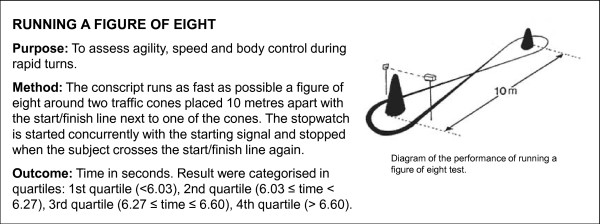
Description of running a figure of eight test. The test was performed for study purposes.